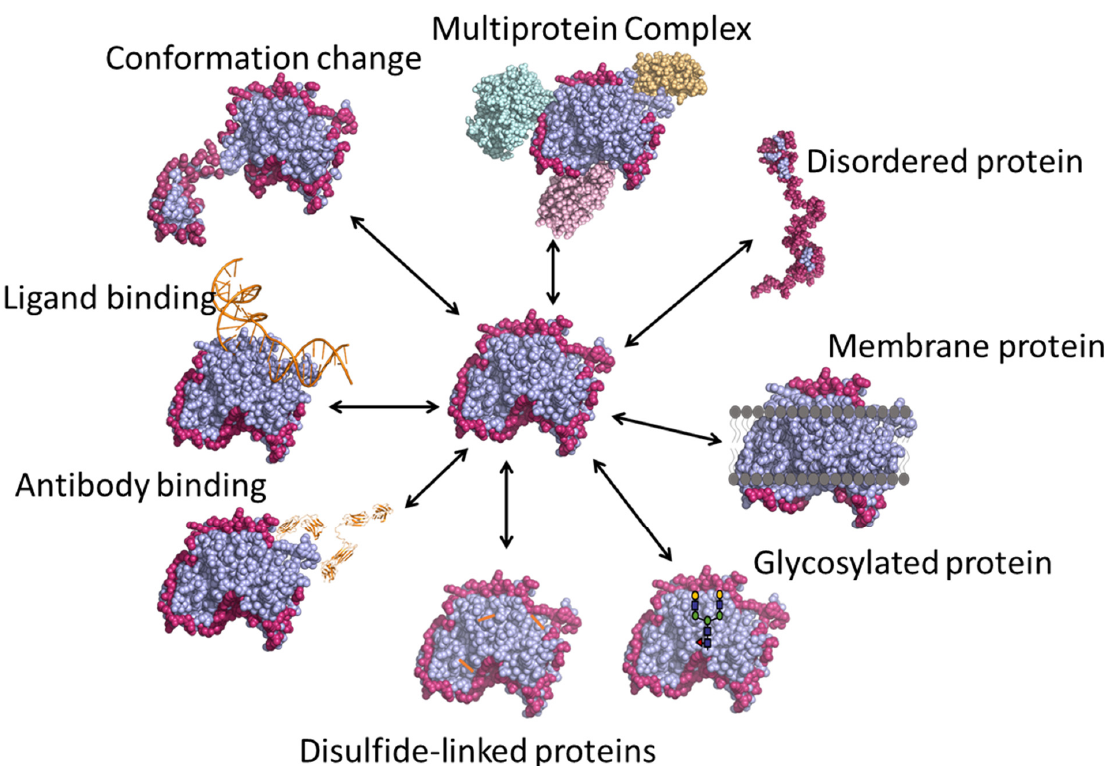
Figure 4. Various applications of HDX-MS technique.